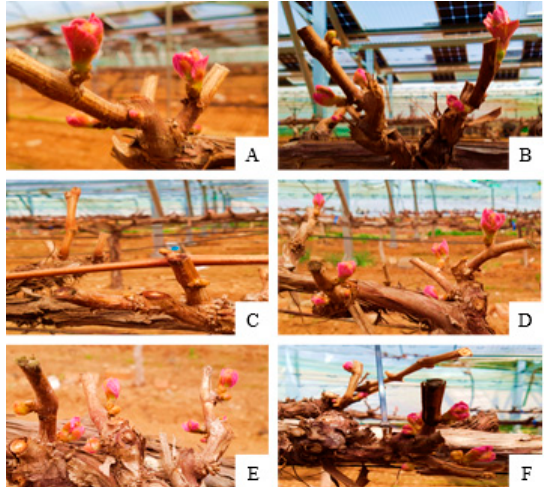
Figure 20. Grape germination (20 April 2019). ( A ) Normal control site, ( B ) normal solar-panel site, ( C ) bifacial control site, ( D ) bifacial solar-panel site, ( E ) transparent control site, and ( F ) transparent solar-panel site.